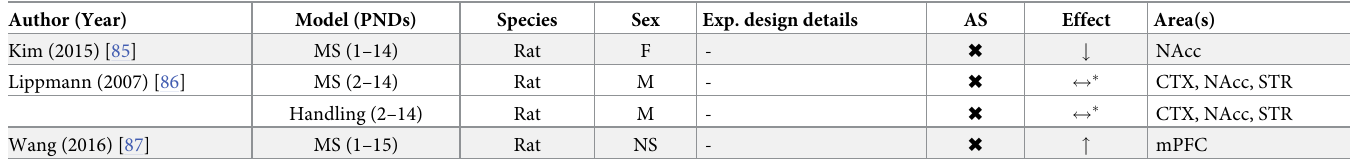
Table 4. Overview of study designs and findings of reviewed publications reporting on Δ FosB expression in ELA and control animals. Author (Year)